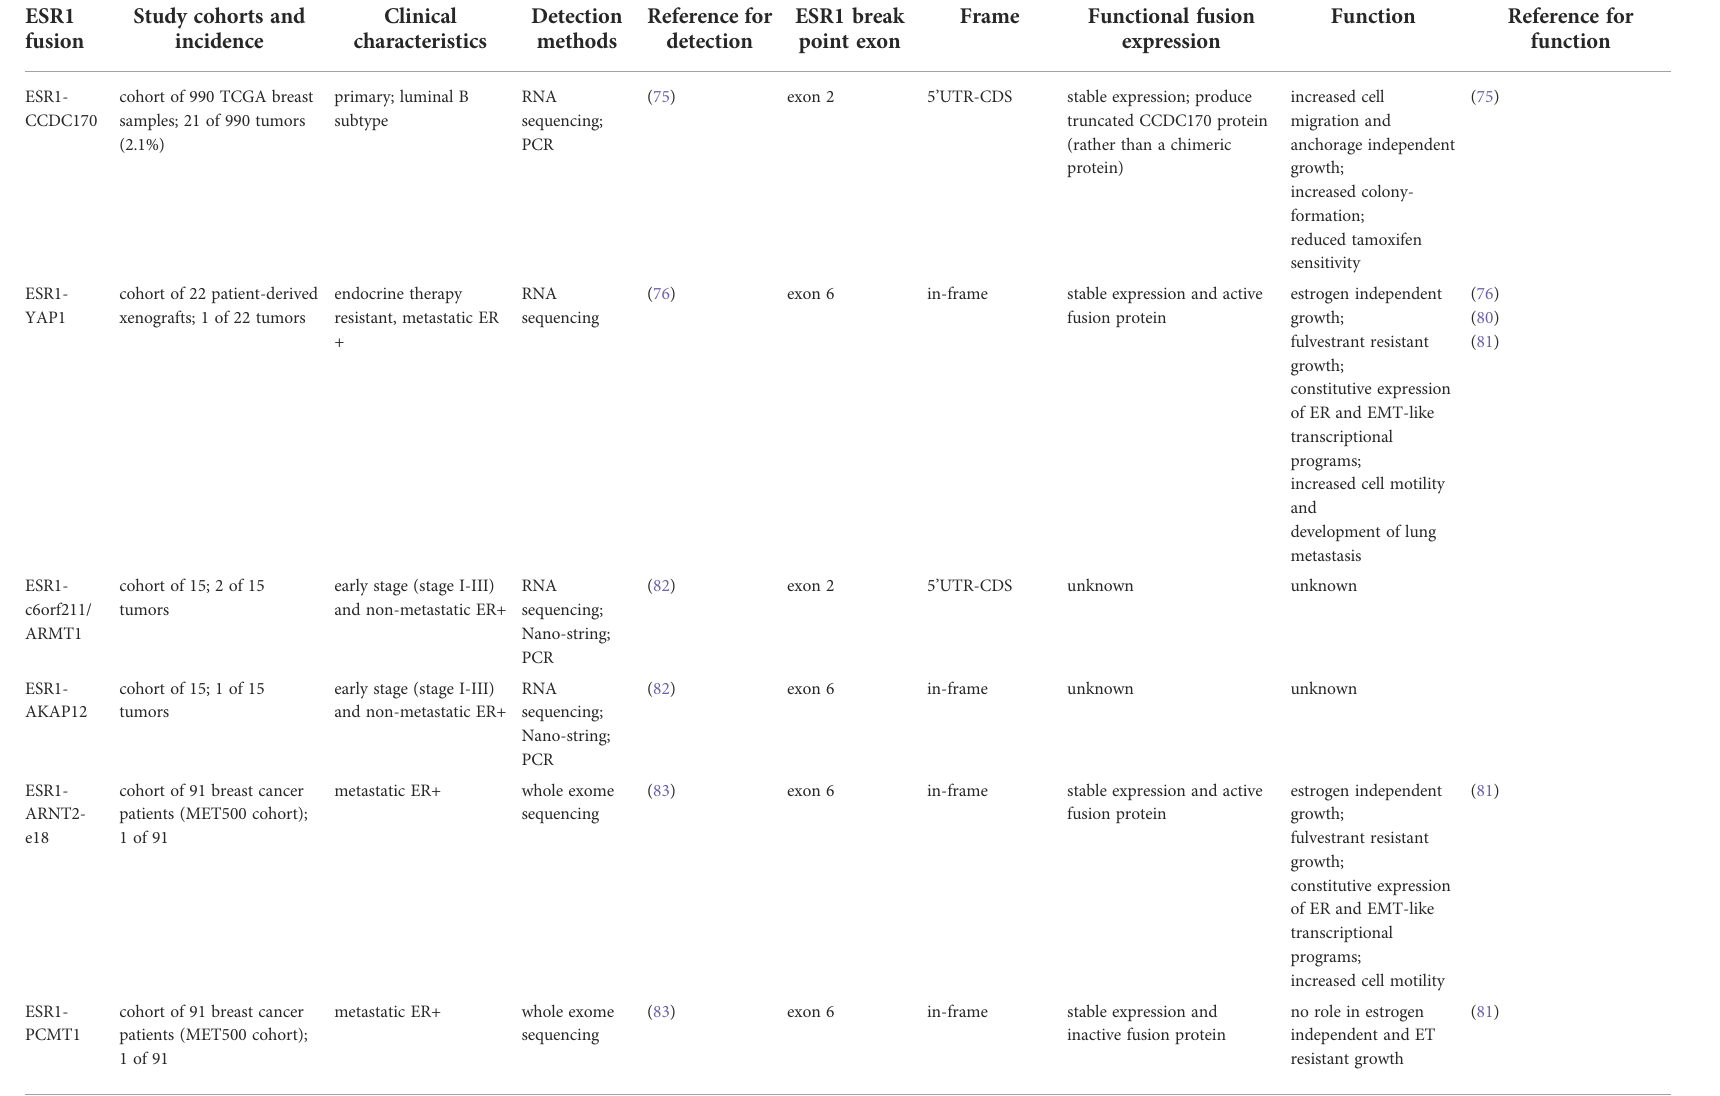
TABLE 1 Summary of ESR1 gene fusions identi fi ed in breast